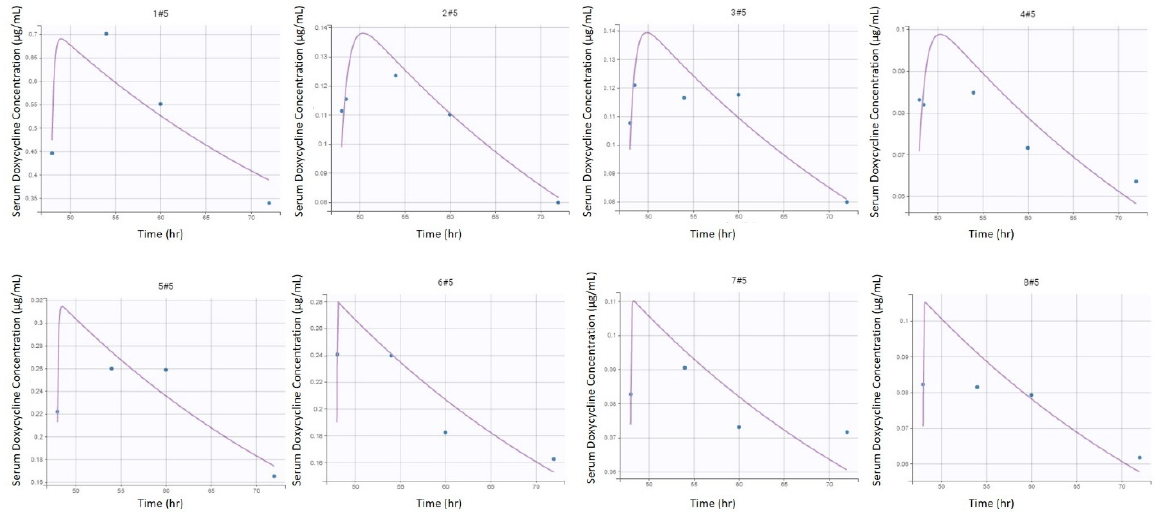
model ( n = 8). Scatter plot of observed (blue dot) and predicted (dashed purple line) individual concentration vs. time after